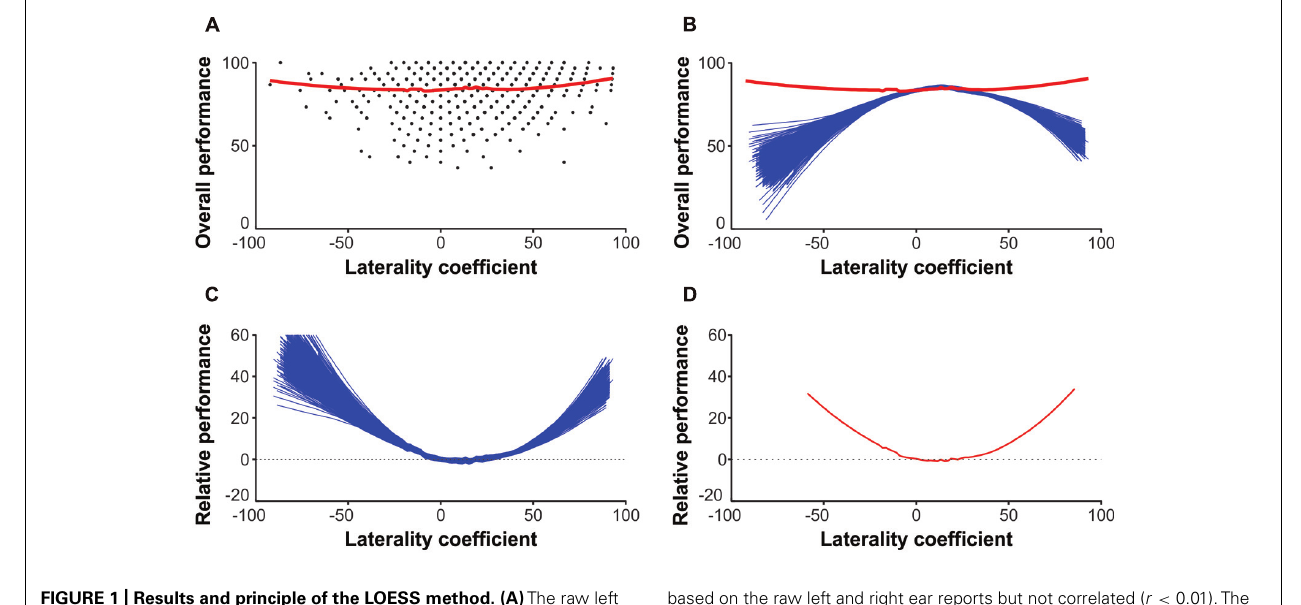
FIGURE 1 | Results and principle of the LOESS method. (A) The raw left and right ear reports are used to compute the laterality coefficient and the overall accuracy. Laterality coefficient and overall accuracy are fitted with LOESS (red line). (B) Reference models (blue lines) are computed which are